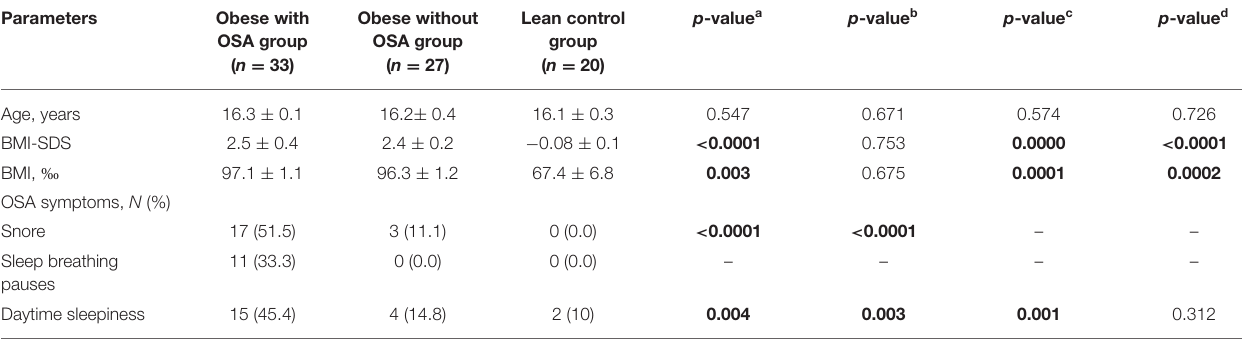
TABLE 1 | Baseline study group’s characteristics.